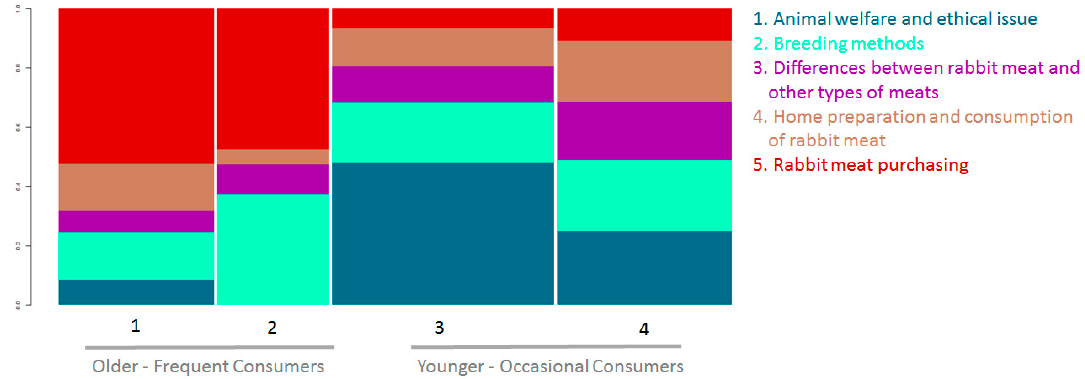
Figure 3. Distribution of the clusters identified among the four focus groups.